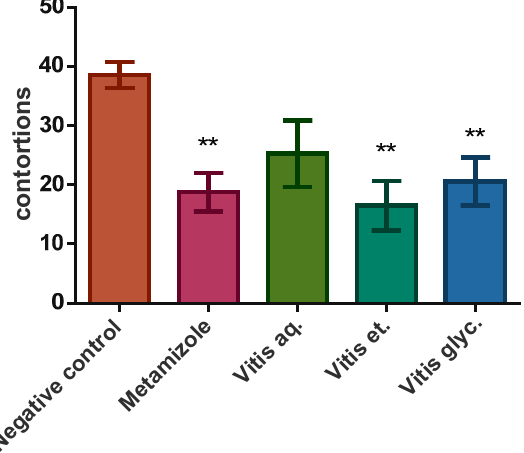
Figure 3 . Mean number of writhes for each group after treatment and acetic acid injection (mean ± SD). The V. vinifera ethanolic extract was associated with the most potent decrease in the number of writhes (** p < 0.01). Metamizole and the glycerolic extracts showed a slightly lower analgesic effect (** p < 0.01). The V. vinifera aqueous extract reduced the number of writhes, but the difference with respect to the control was not statistically significant ( p > 0.05).